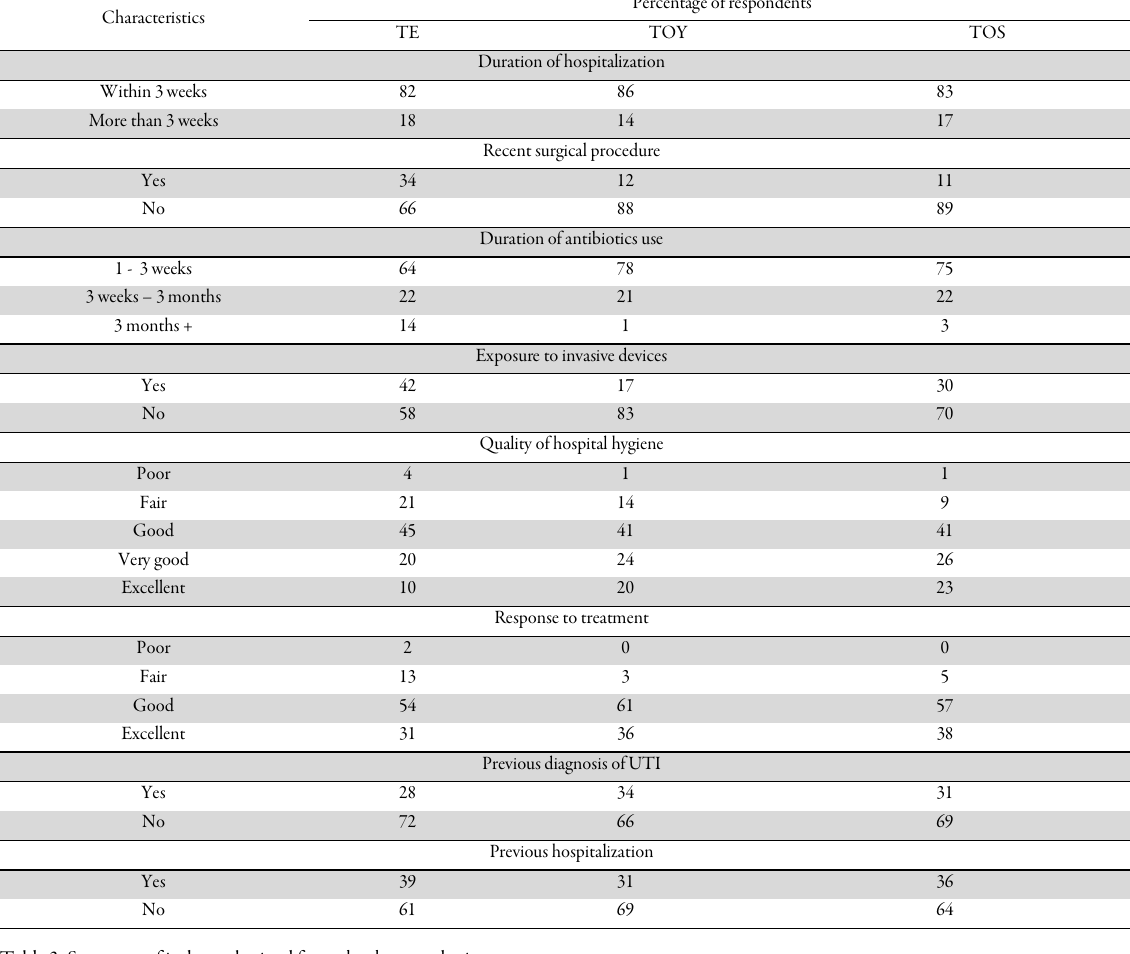
Table 2. Risk factors evaluated among subjects Characteristics